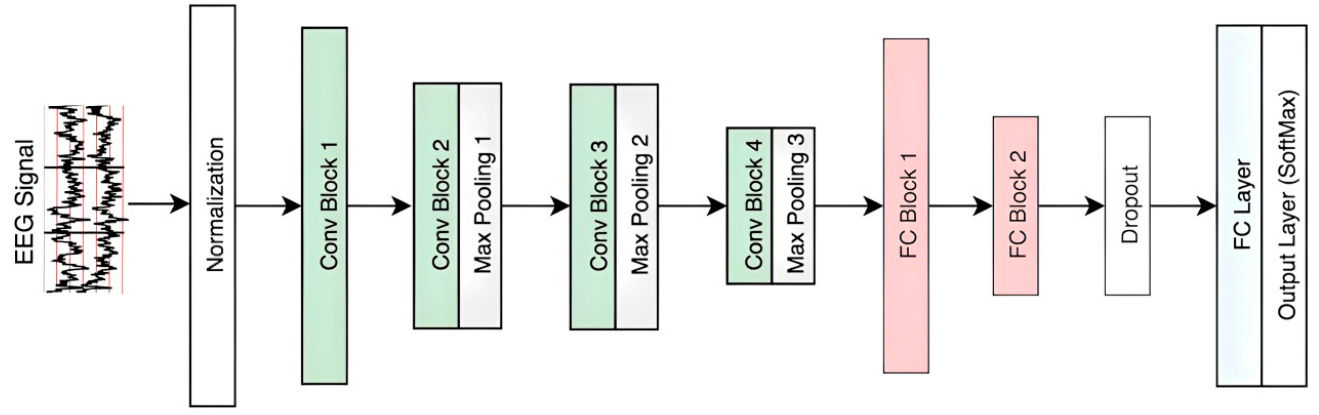
Figure 4. Building Blocks of the CNN Model. ( a ) CONV Block, ( b ) FC Block.